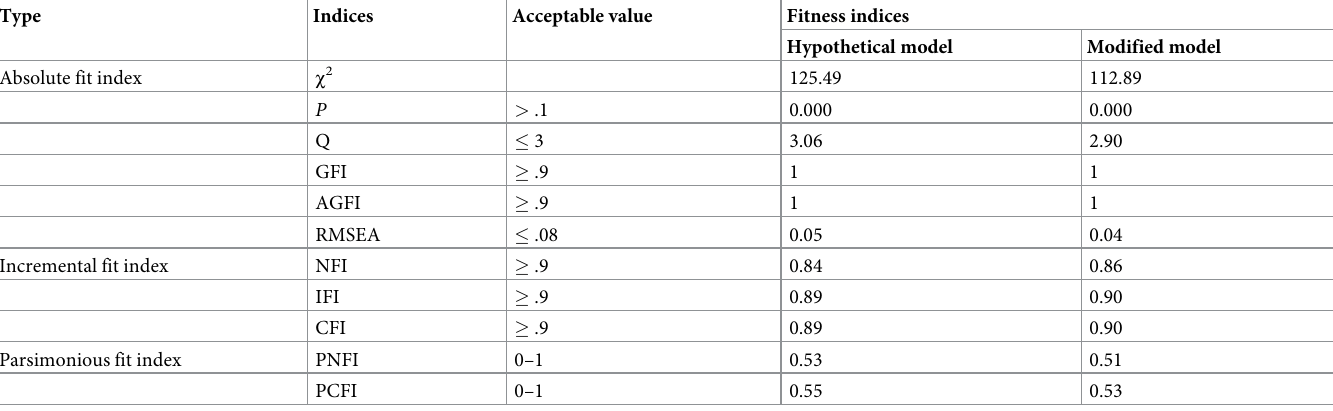
Table 3. Comparison of model fit of the modified model to the hypothetical model.